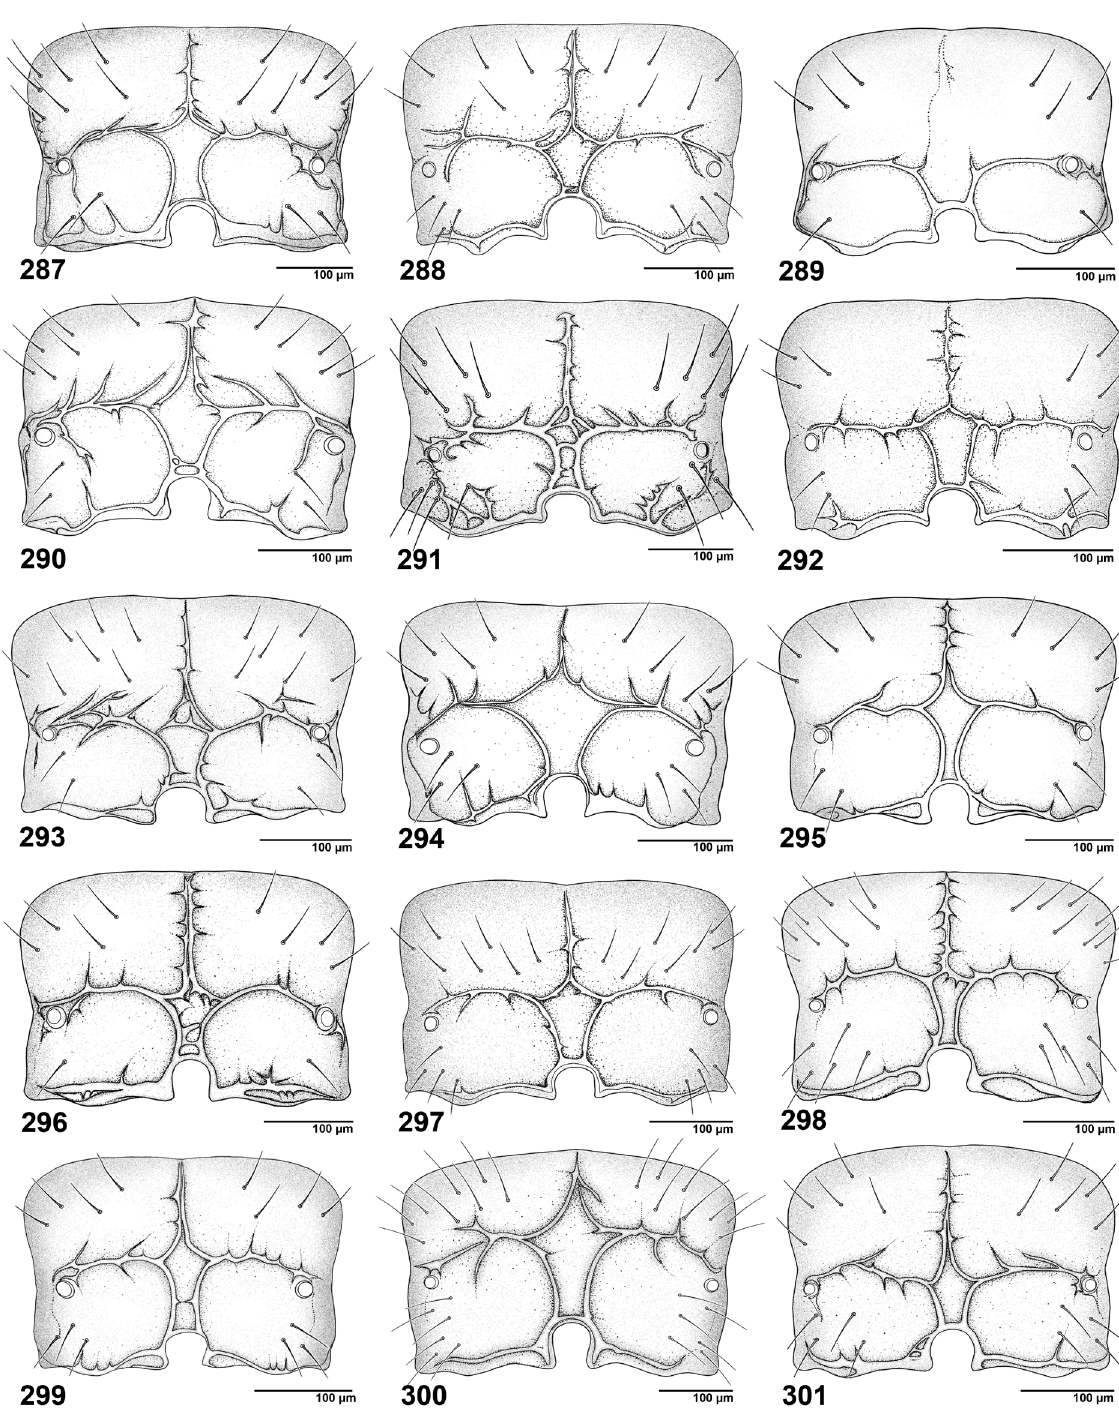
Figs 287–301. Dorsal aspect of propodeum (♀): 287 . Aphidius funebris . 288 . Aphidius hieraciorum . 289 . Aphidius iranicus . 290 . Aphidius matricariae . 291 . Aphidius microlophii . 292 . Aphidius myzocallidis . 293 . Aphidius persicus . 294 . Aphidius platensis . 295 . Aphidius popovi . 296 . Aphidius rhopalosiphi . 297 . Aphidius ribis . 298 . Aphidius rosae . 299 . Aphidius salicis . 300 . Aphidius setiger . 301 . Aphidius smithi